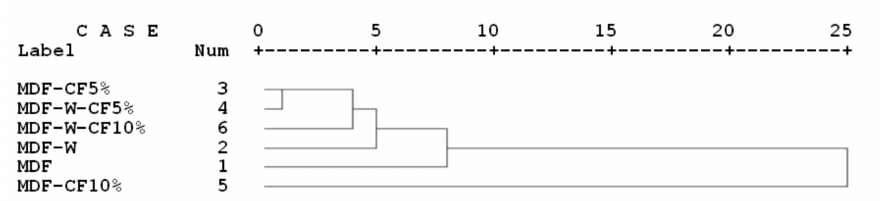
Figure 1. Cluster analysis of the effect of chicken feathers (CF) and wollastonite (W) on fire perfor- mance properties of wood-based medium density fibreboard